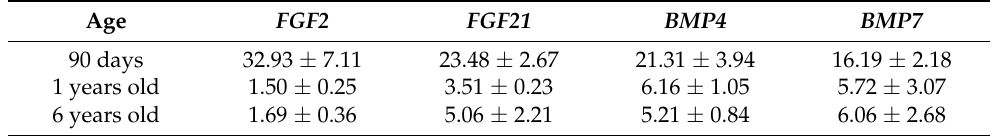
Table 1. The expression of RNA in skin samples of different